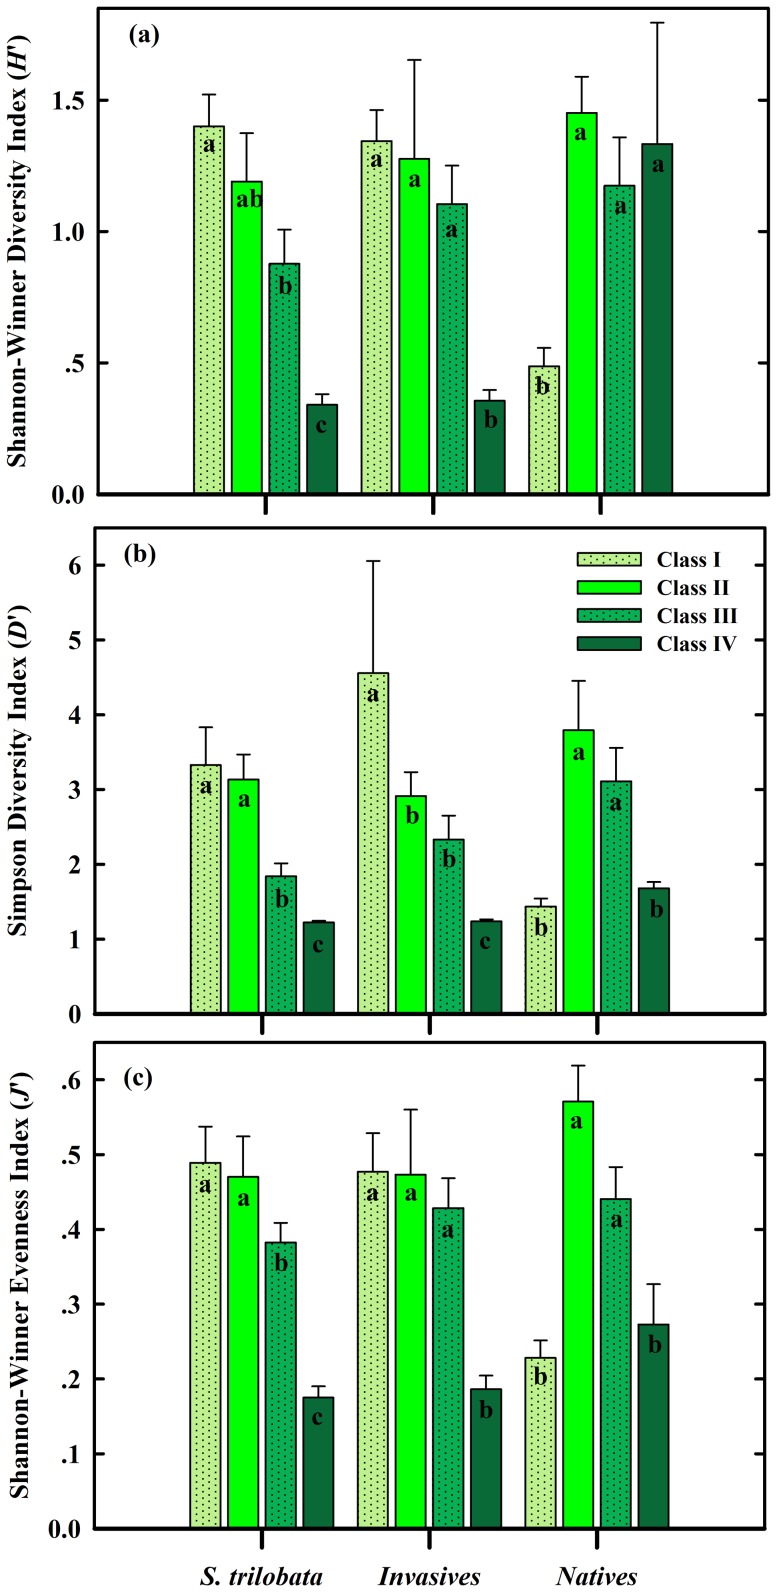
Mean biodiversity of the plant communities among four classes of cover (I, II, III, IV) within the community composition (S. trilobata, all invasive plants, and all native plants).(a): Shannon-Wiener's species diversity index (H′); (b): Simpson's dominance index (D′); (c): Shannon-Wiener's evenness index (J′). For each variable, means labeled with the same letter are not significantly different according to Duncan's multiple-range test at the p = 0.05 level.